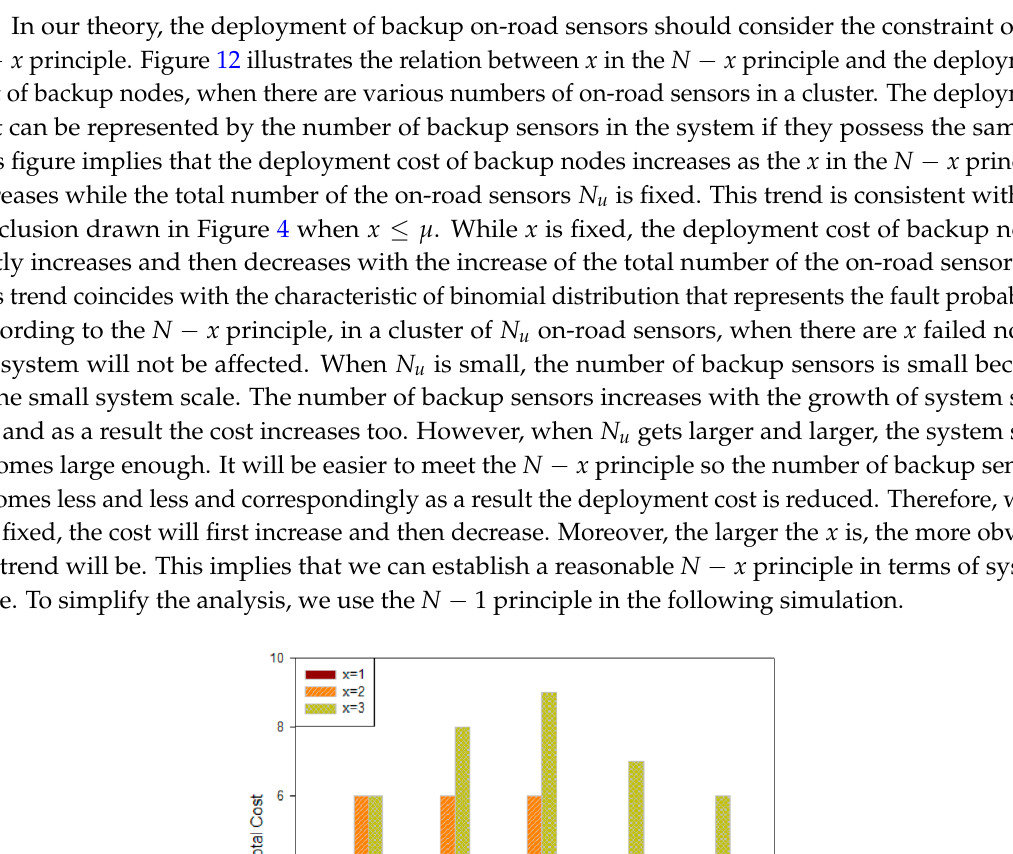
Figure 13. Convergence comparison between the proposed and other algorithms.